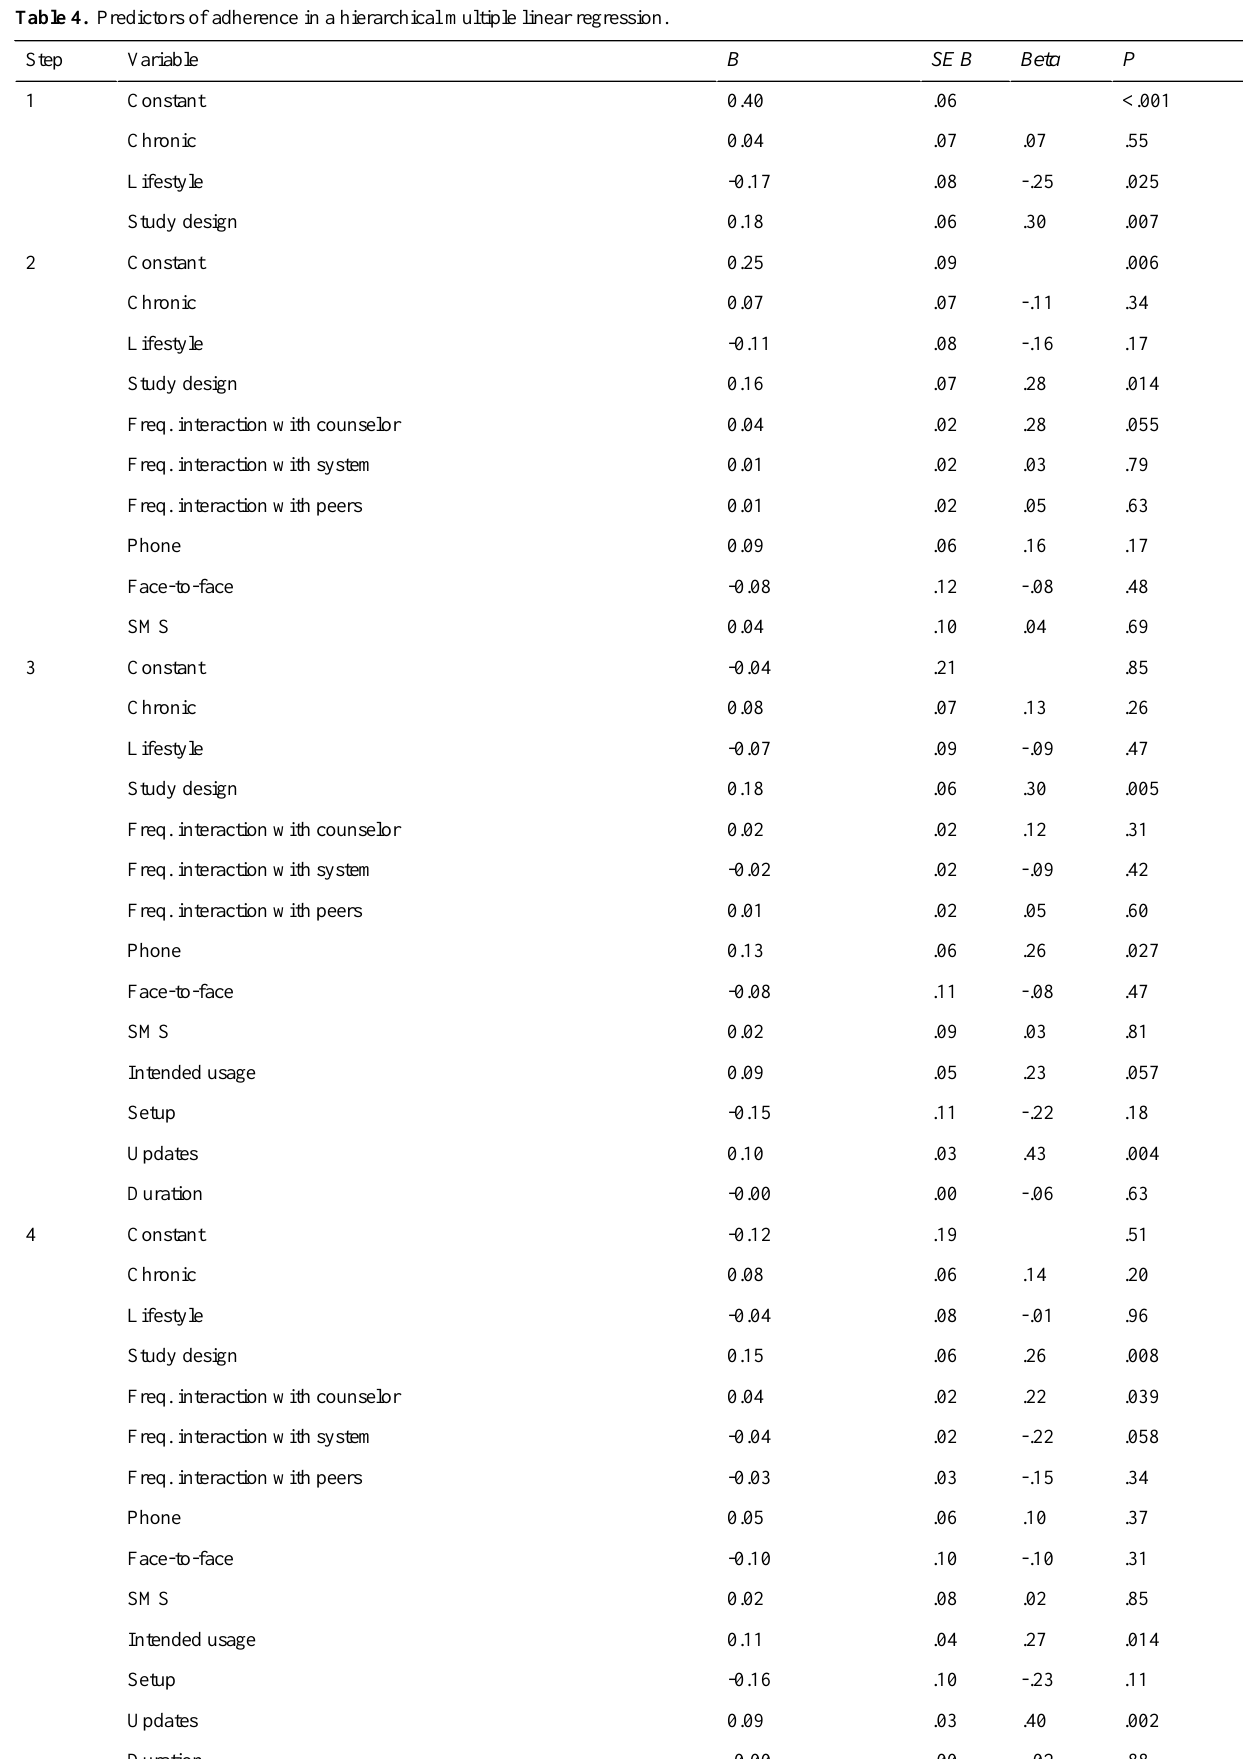
Table 4. Predictors of adherence in a hierarchical multiple linear